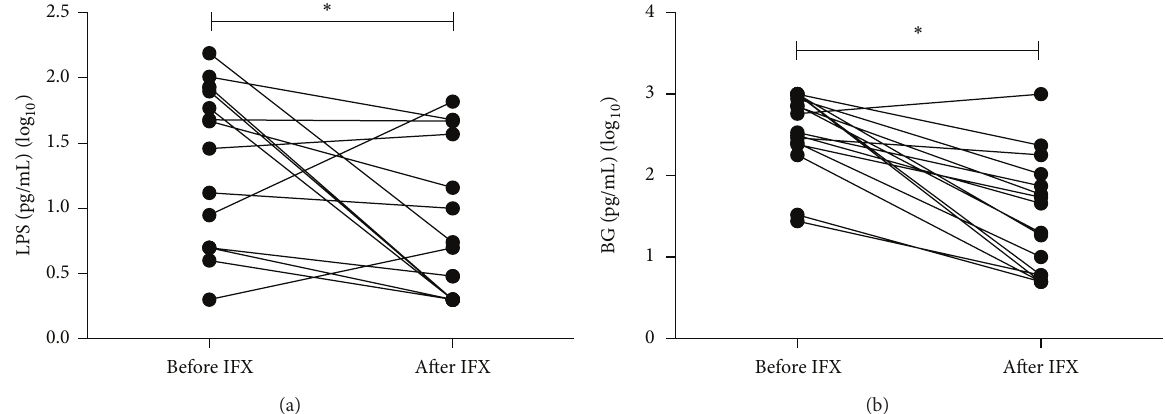
Figure 5: The levels of LPS and BG are decreased with IFX. Sixteen A-CD patients received IFX at a dose of 5mg/kg body weight at weeks 1, 2, and 6. The sera were collected 12 weeks after IFX therapy and analyzed for LPS and BG. (a) The levels of LPS were significantly decreased ( ∗ 𝑃 < 0.05 ) as compared with those before IFX treatment. (b) The levels of BG were significantly decreased ( ∗ 𝑃 < 0.01 ) as compared with those before IFX